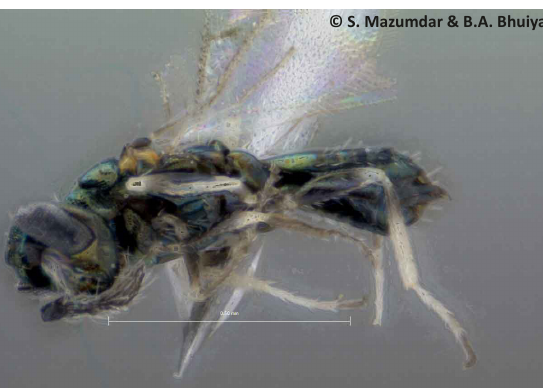
Image 1. Chrysocharis pentheus (Walker, 1839), lateral